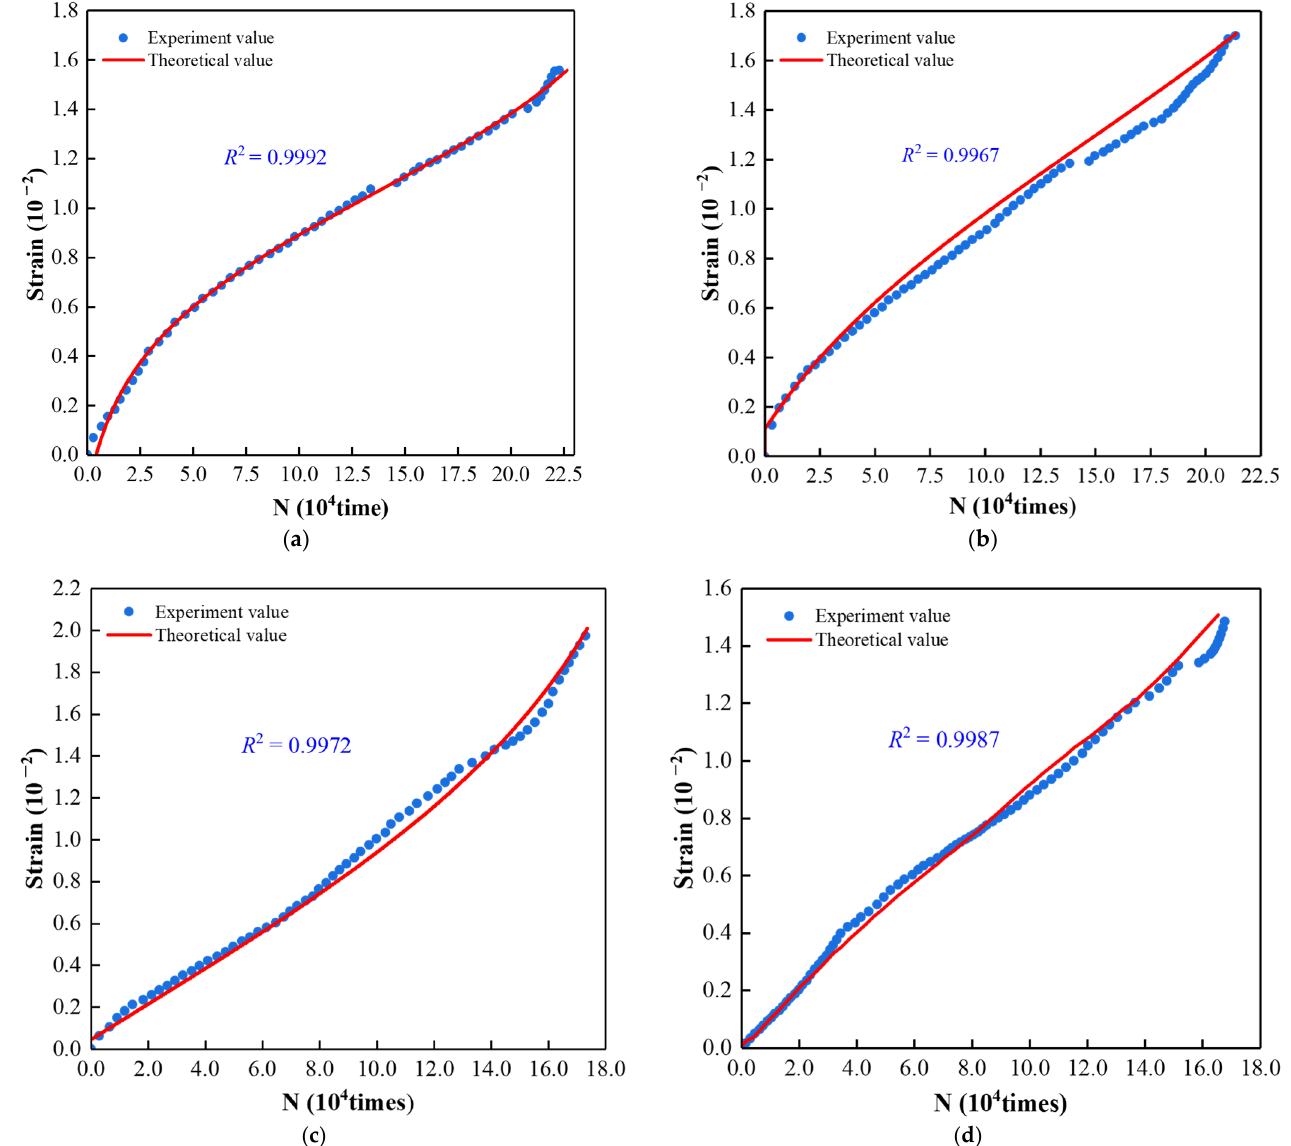
Figure 11. Comparison of Experiment value and Theoretical value of N and ε . ( a ) 0.002; ( b ) 0.005; ( c ) 0.0075; ( d ) 0.01.